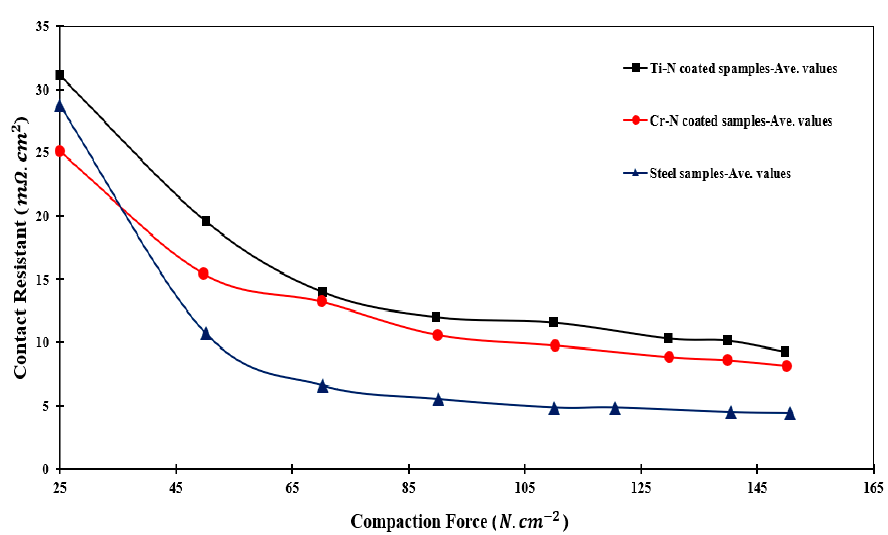
Figure 14. The comparison of the ICR of various specimens including uncoated SS, TiN-coated 410 SS, and CrN-coated 410 SS [23].